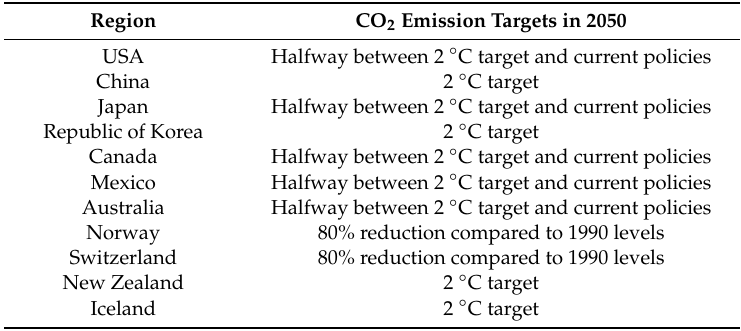
Table A2. Emission targets for regions outside of the EU-28 pursuing emission cuts higher than the current policies for the regional push world